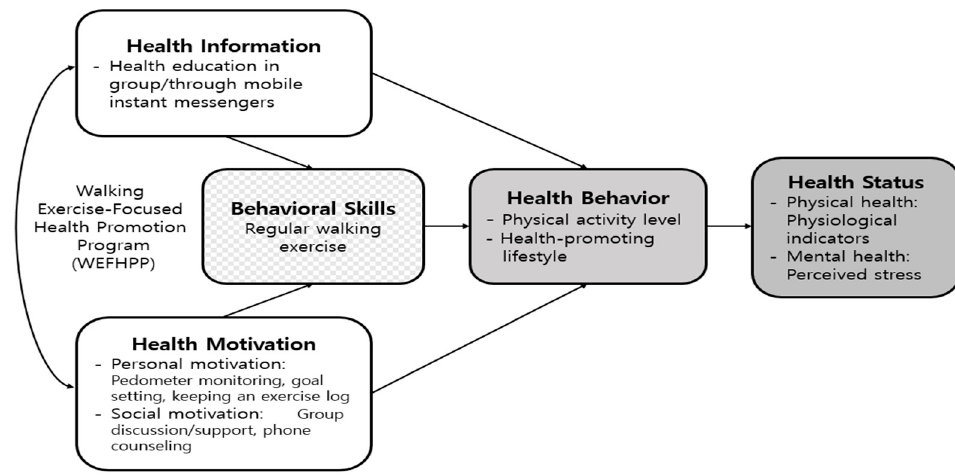
Figure 1. Conceptual framework of this study.